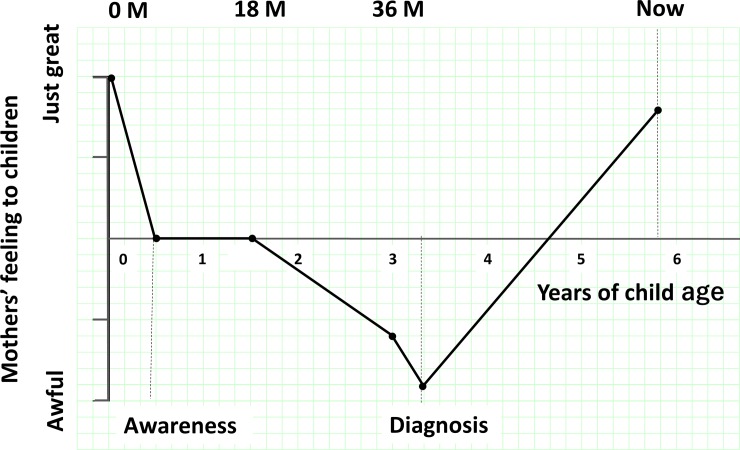
An example of the VAS scores of mothers’ feelings for their ASD children drawn on graph paper.